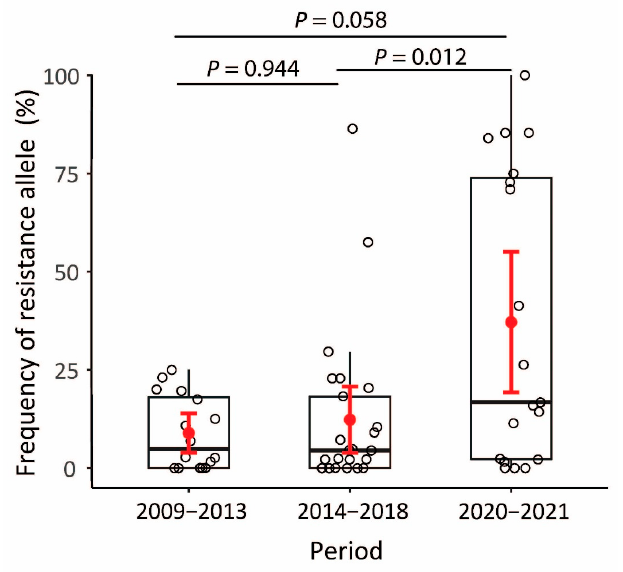
Figure 3. Plot of G275E-resistant allele frequencies in three collecting periods. The horizontal black solid line represents the median for each period; the red dot represents the mean. Red error bars indicate the standard error.